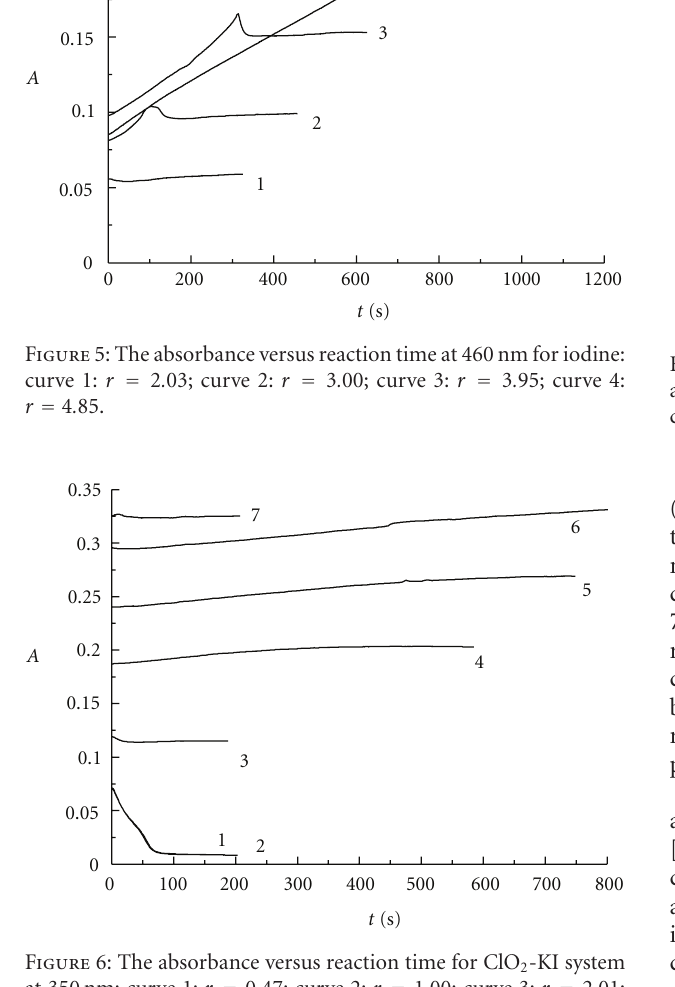
Figure 6: The absorbance versus reaction time for ClO 2 -KI system at 350nm: curve 1: r = 0 . 47; curve 2: r = 1 . 00; curve 3: r = 2 . 01; curve 4: r = 3 . 02; curve 5: r = 4 . 03; curve 6: r = 5 . 04; curve 7: r = 5 . 92.